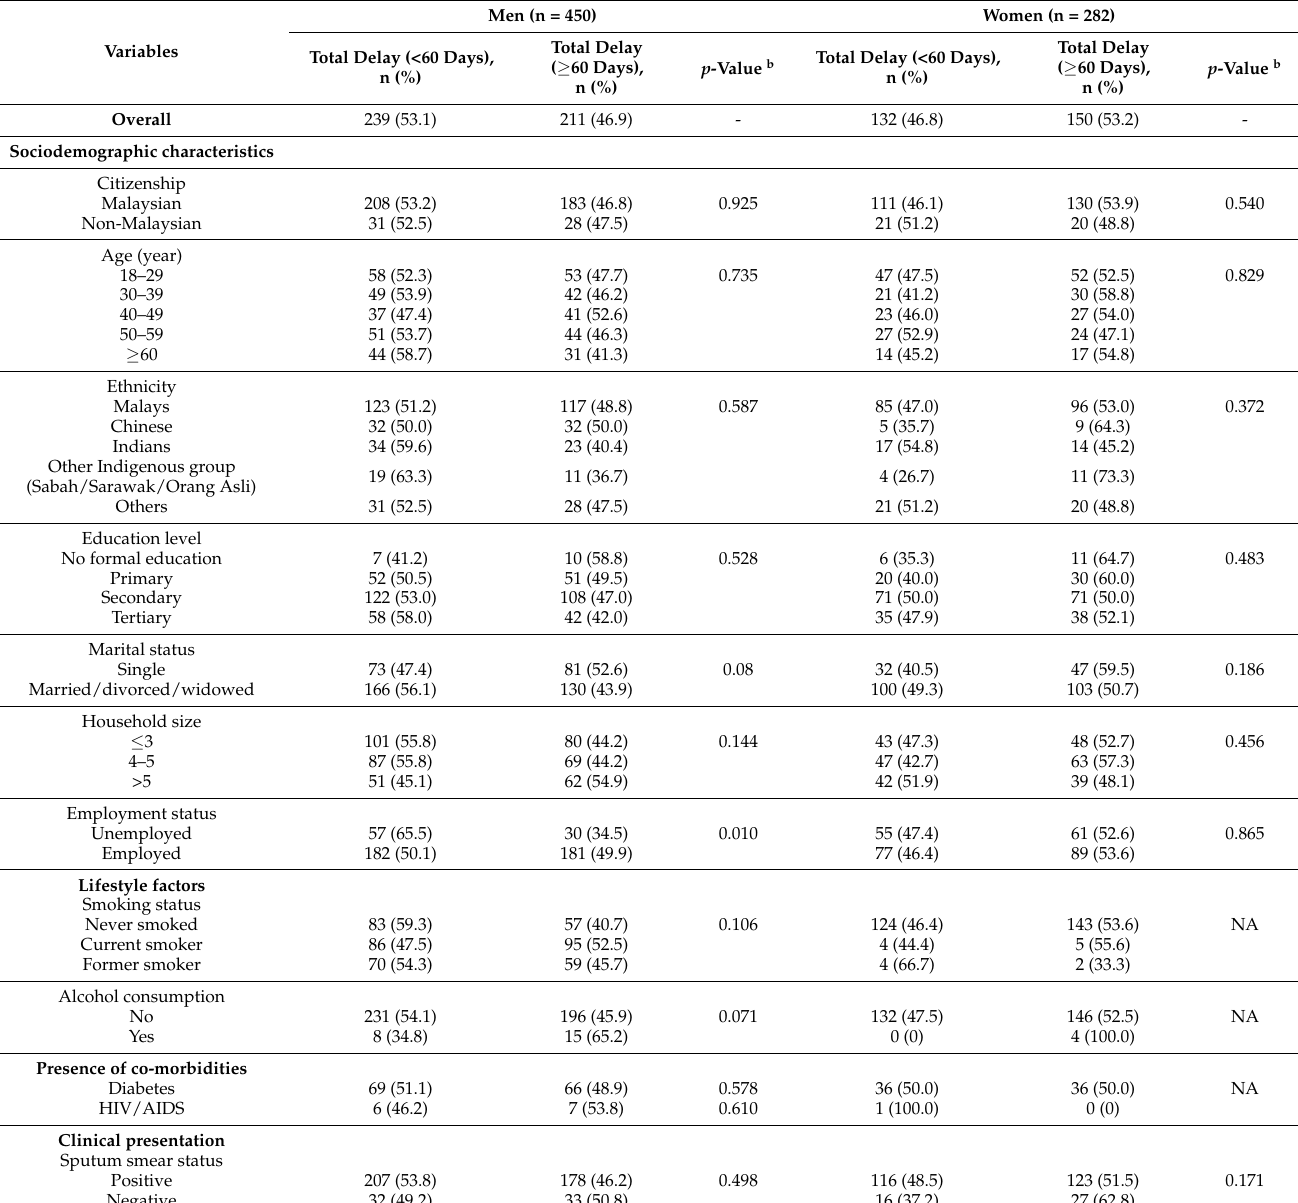
Table 2. Univariable analysis of factors with the total delay, stratified by